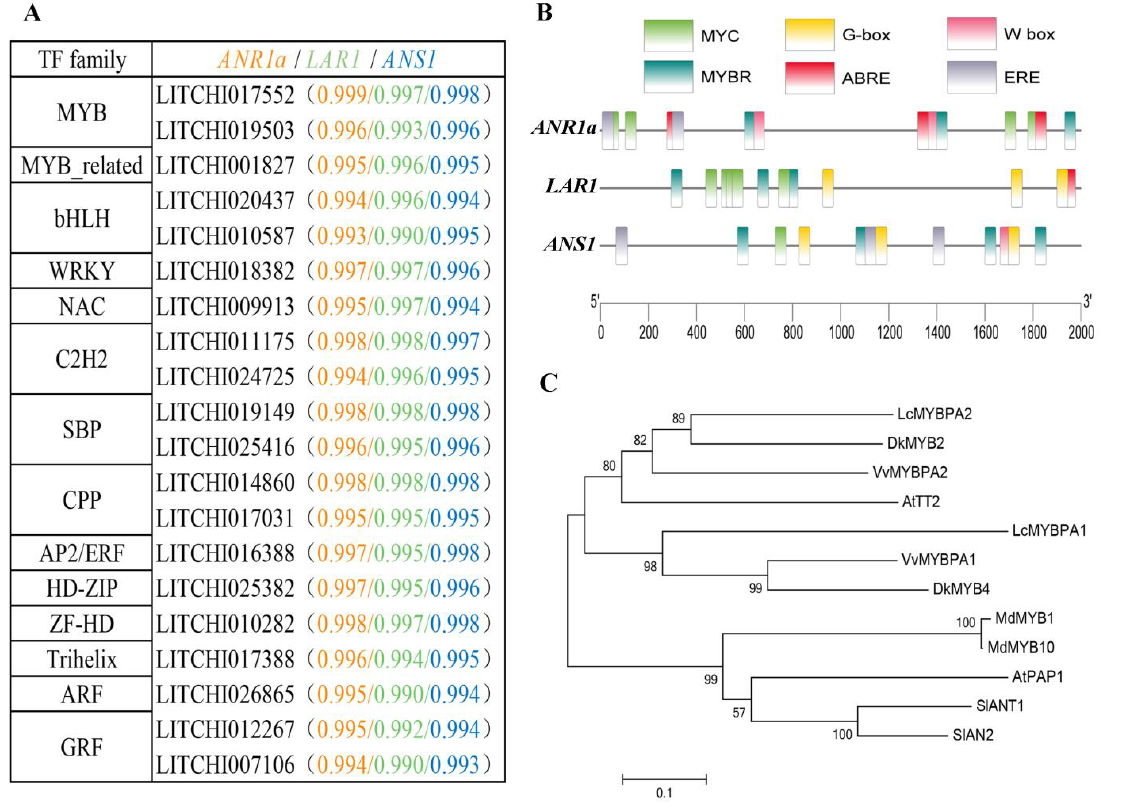
Figure 7. ( A ) The top 20 transcription factors (TFs) showing high correlation with PA biosynthesis candidate genes ( ANR1a , LAR1, and ANS1 ). ( B ) Cis-regulatory elements detected in 2000 bp upstream of ANR1a / LAR1 / ANS1 genes based on PlantCARE analysis. ( C ) Rooted neighbor-joining phyloge-